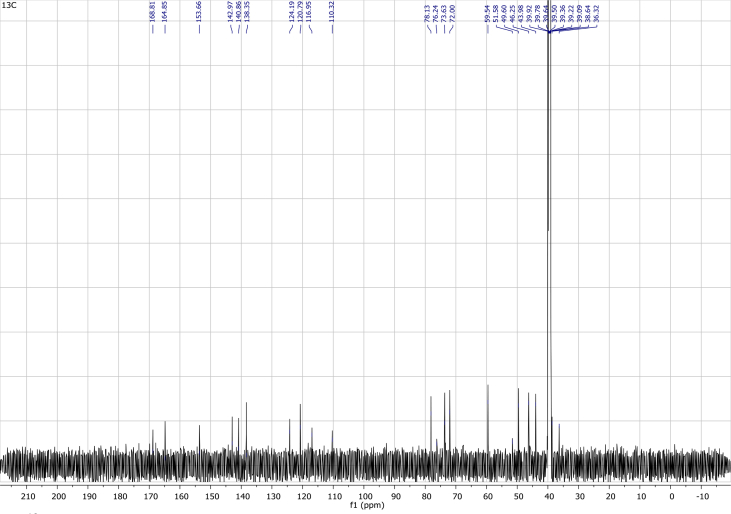
13C NMR (DMSO-d6) spectrum of compound 12.